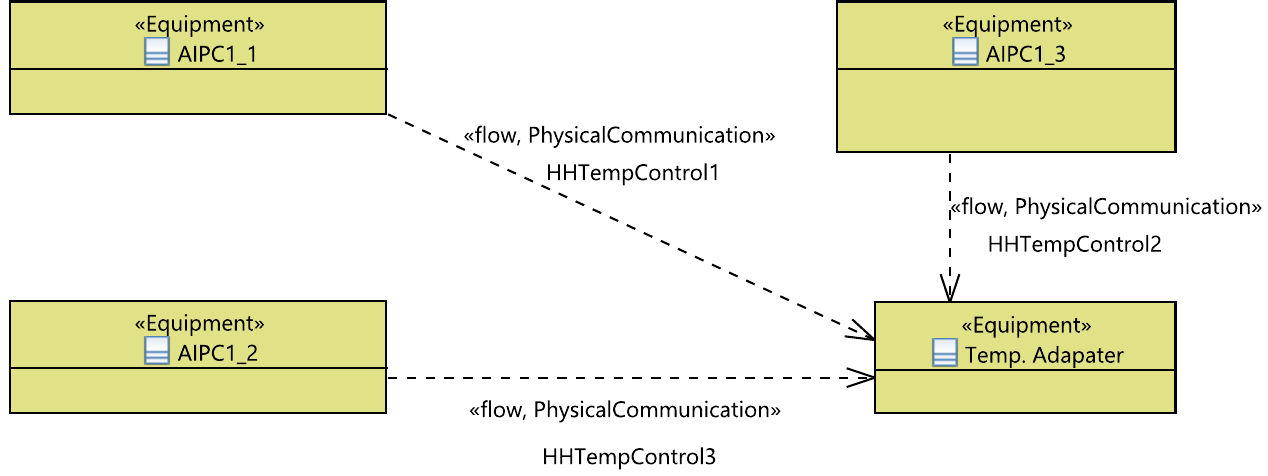
Figure 22. Communication links between the equipment implementing different